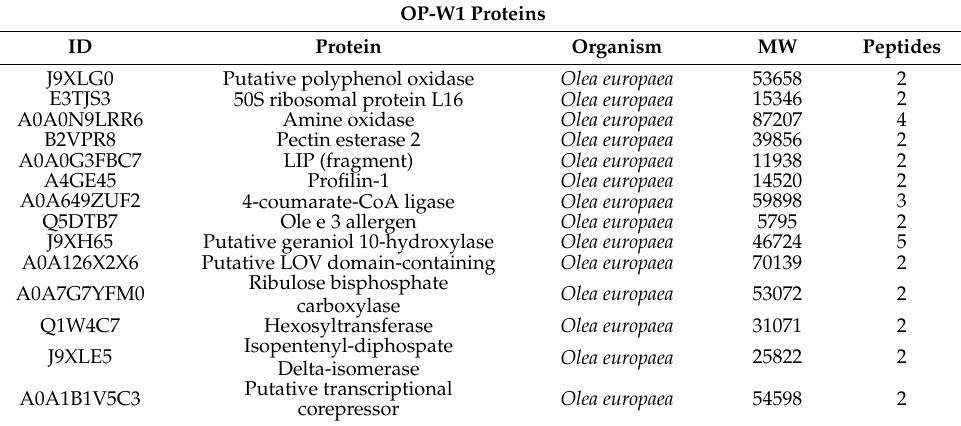
Table 7. List of identified OP-W1 peptides and corresponding proteins by LC-MS/MS analysis. The databases consulted were FASTA-file Olea and Olea europaea (common olive).